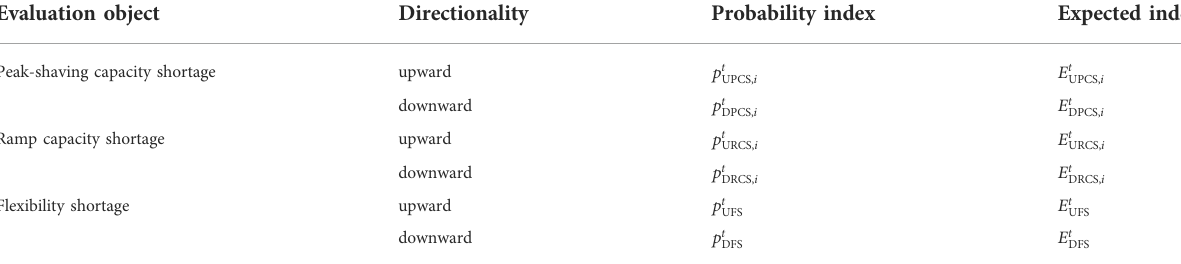
TABLE 1 Some power system fl exibility evaluation